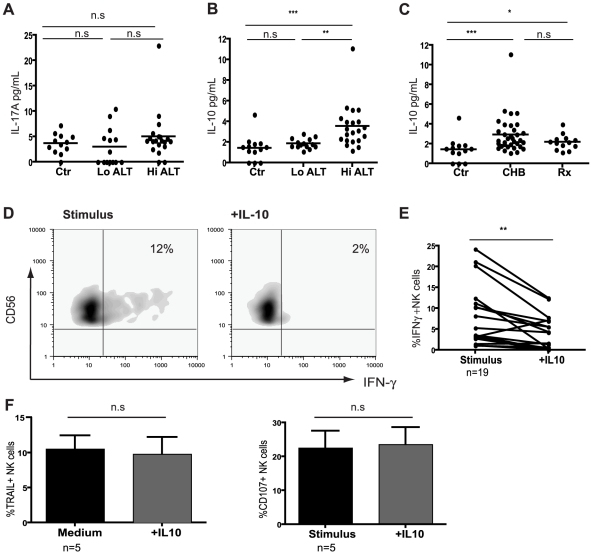
IL-10 is elevated in CHB and suppresses NK cell IFN-γ production.(A) Levels of cytokines IL-17A and (B) IL-10 determined using Cytometric Bead Arrays flex sets using sera from 13 healthy controls, 14 low ALT (median ALT 35, all eAg-) and 21 high ALT patients (median ALT 115, 13eAg-). (C) Cumulative IL-10 results including therapy group (n = 13, median ALT 25). (D) Representative density plots of the effect of exogenous IL-10 on IFN-γ production by NK cells from a CHB patient and (E) paired cumulative results from 19 CHB patients. (F) Summary bar charts of the effect of exogenous IL-10 on the expression of TRAIL and CD107 in 5 CHB patients. Results are paired and expressed as mean ± SEM. Stimulus  =  IL12+IL18. Significance determined by the Mann-Whitney test for comparison between groups and the Wilcoxon signed rank test for paired data, *p<0.05, **p<0.01, ***p<0.001.